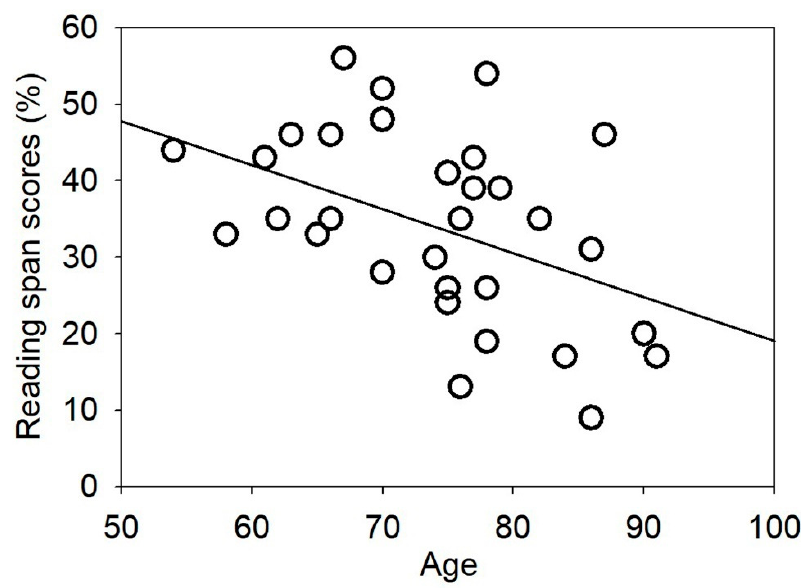
Figure 4. Scatter plot showing the correlation between the participants’ reading span scores and their age (r = − 0.453). The straight line is the regression line.